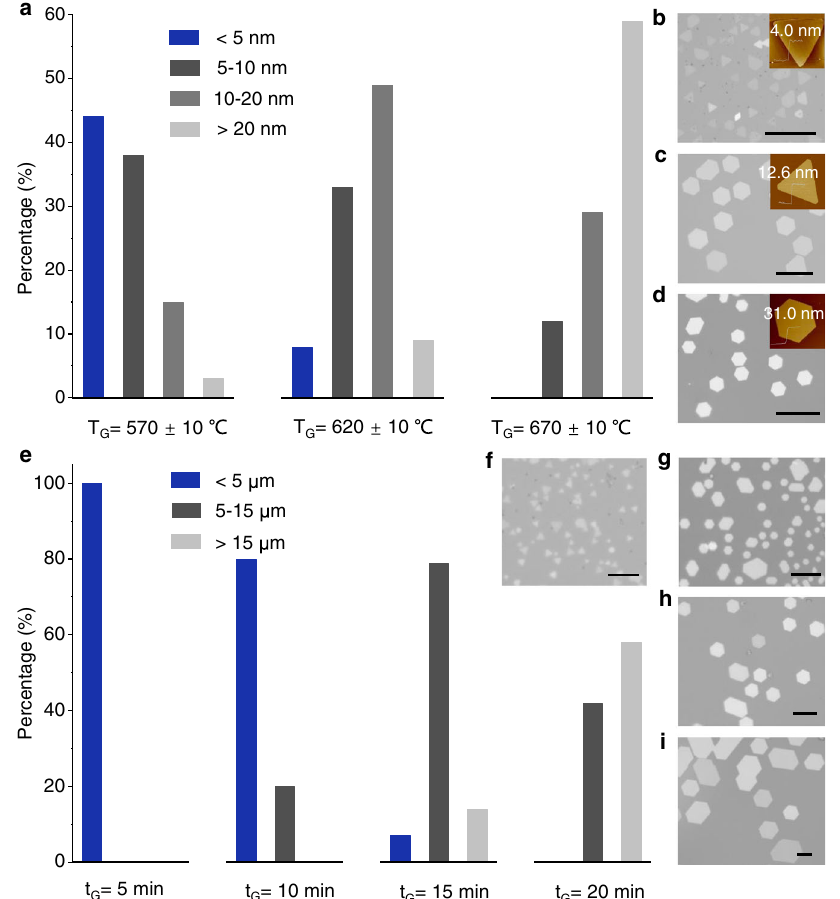
Fig. 2 | Thickness-tunable and size-tunable synthesis of nanoplates by varying the growth temperature (T G ) and growth time (t G ). a The statistical thickness distributions of the MnS nanosheets synthesized with T G of 570±10°C, 620±10°C,and670±10°C,respectively. b – d TypicalOMimagesandAFMimages (inset) of the MnS nanosheets synthesized with T G of 575°C ( b ), 630°C ( c ), and